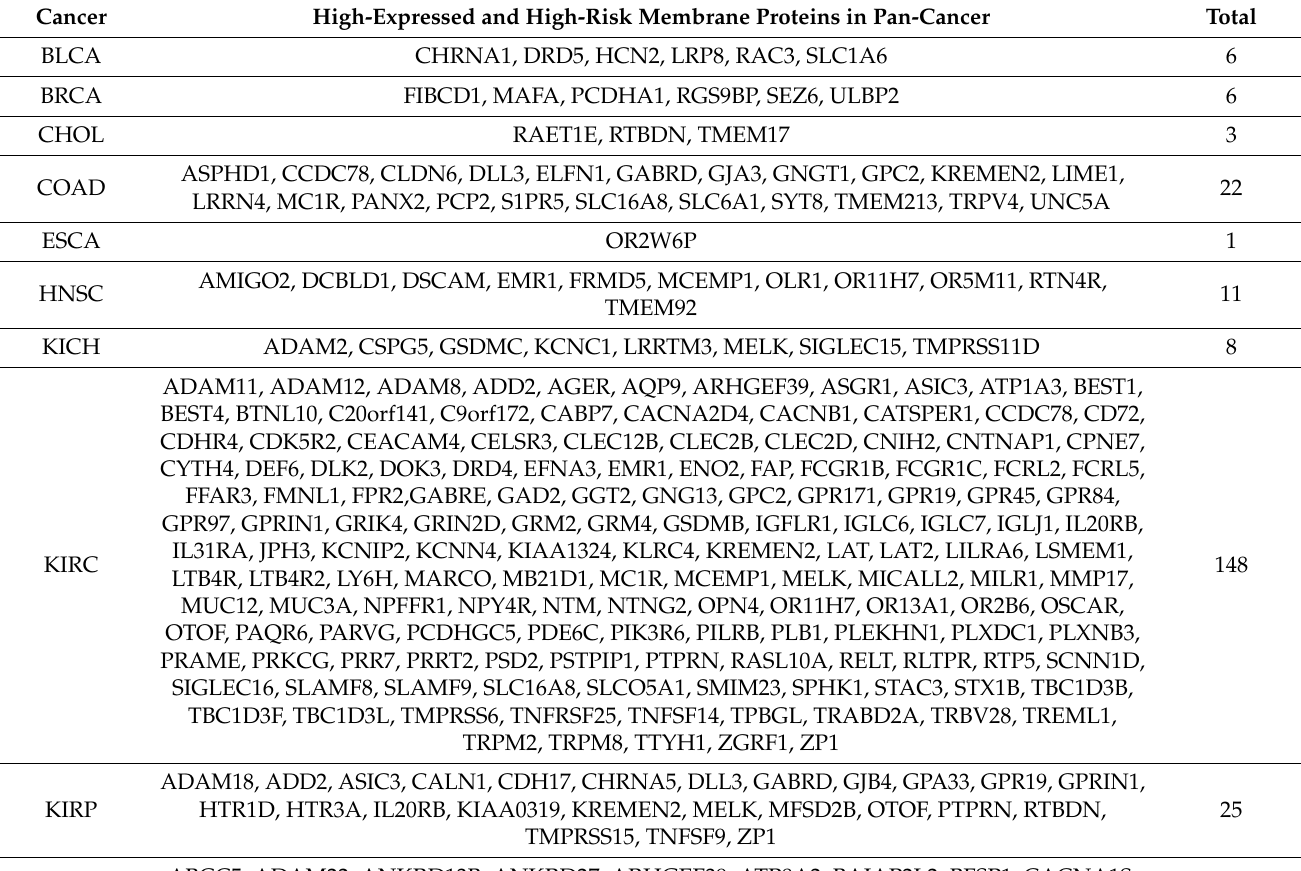
Table 2. The surface proteins with high-expression and high-risk in various cancer types. Cancer High-Expressed and High-Risk Membrane Proteins in